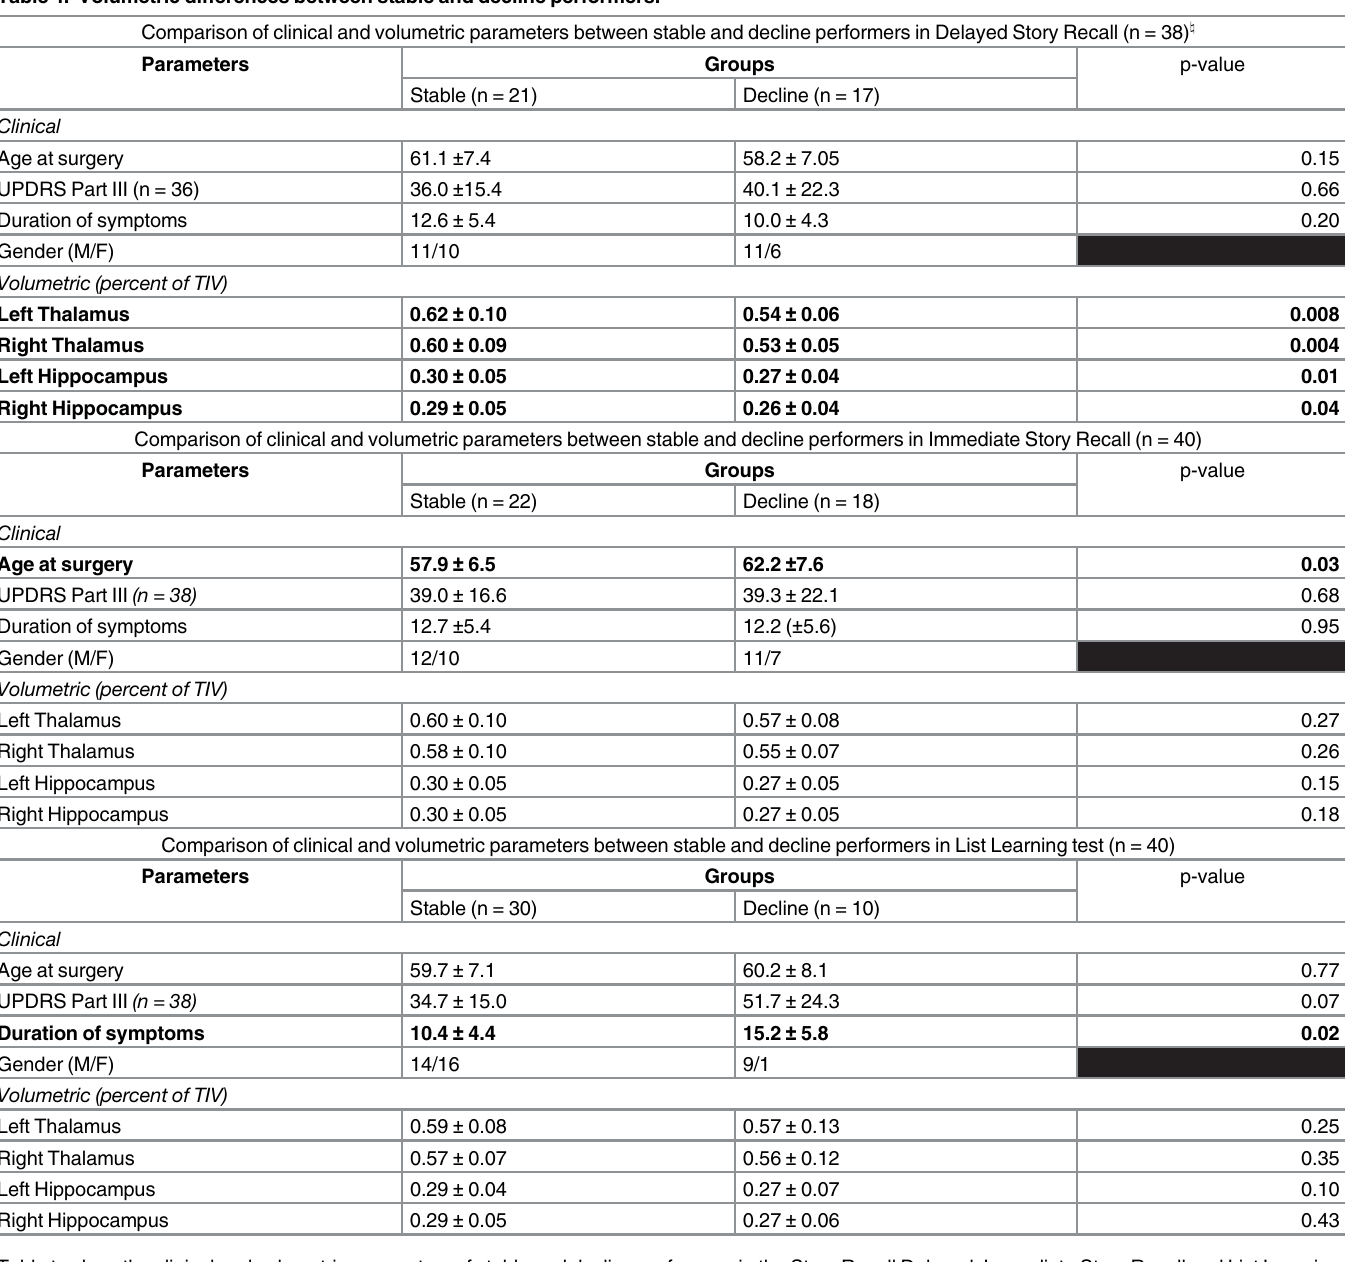
Table to show the clinical and volumetric parameters of stable and decline performers in the Story Recall Delayed, Immediate Story Recall and List Learning tests. A Mann-Whitney U Test was used to assess the difference between clinical and volumetric data between groups. Signi fi cant values are highlighted in bold. \ 2 patients were excluded as complete Story Recall Delayed test data was not